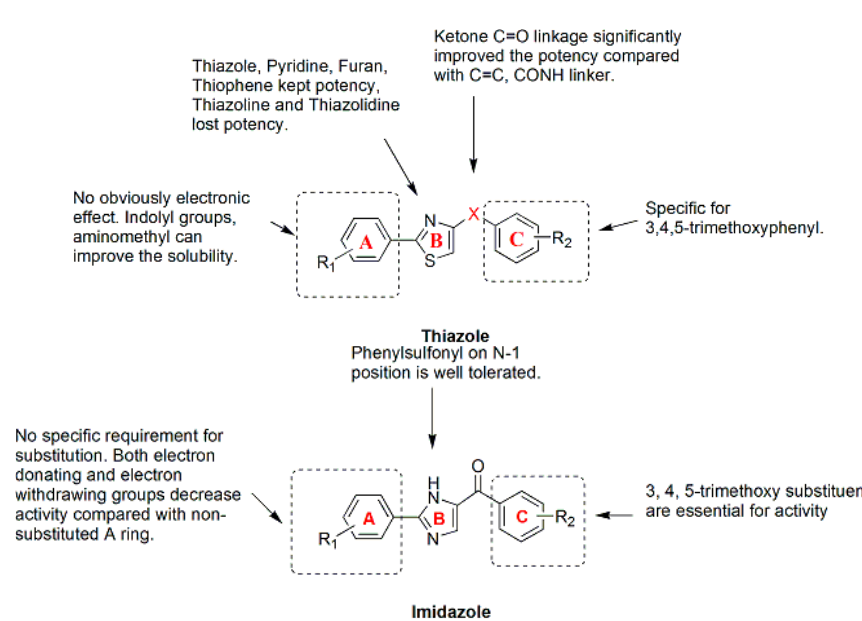
Figure 13. Thiazole and imidazole analogues.